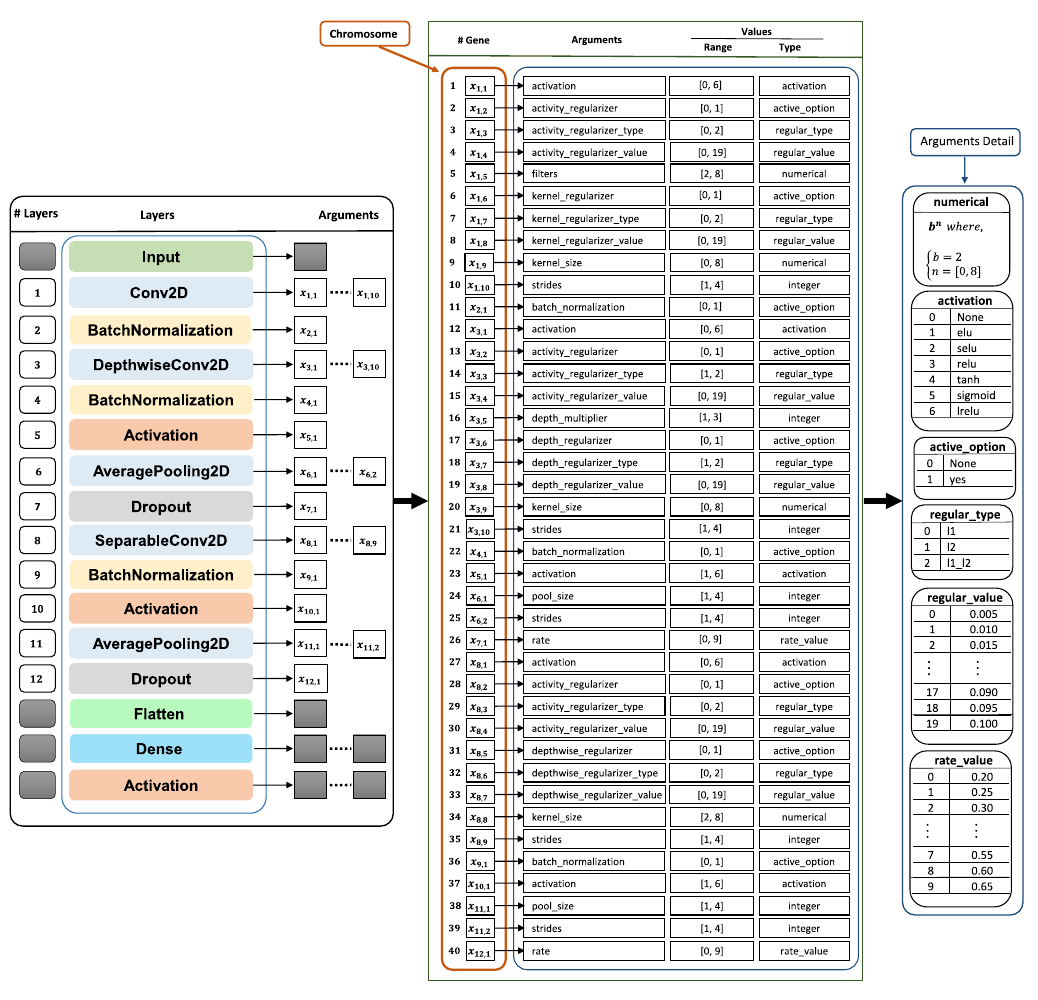
Figure 6. Detailed view of the chromosome that codifies the solutions for evolutionary optimization algorithm (NSGA-II). Figure shows the values used in the optimization of EEGNet architecture shown in this work. However, specific ranges, activation functions, regularization types, etc. can be configured in the database, depending on the specific optimiza- tion